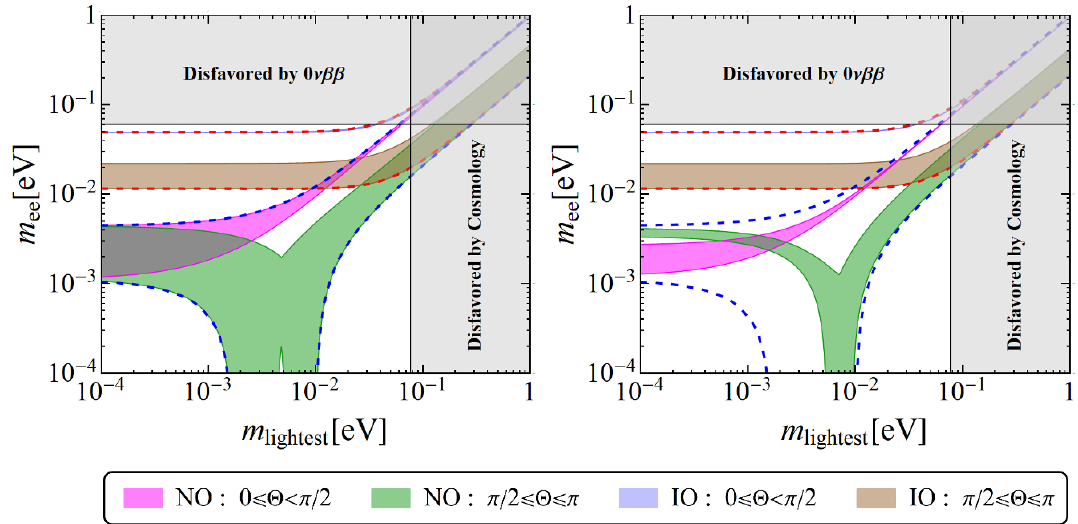
Figure 12 . The same as (cid:12)gure 11 for the generalized e (cid:0) (cid:28) re(cid:13)ection. The CP label (cid:2) is free on the left panel, and we (cid:12)x (cid:2) = (cid:25)= 9 and (cid:2) = 8 (cid:25)= 9 on the right panel. Notice that the IO: 0 (cid:20) (cid:2) (cid:20) (cid:25) region (cyan) is very narrow and is close to the maximum m ee for IO. This region can be tested very soon in neutrinoless double beta decay experiments.